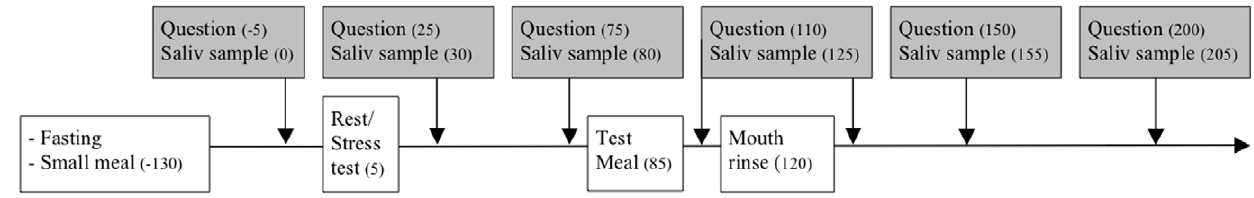
Figure 1. Schematic overview of the study design. Numbers in brackets represent the time points (in min) at which data was collected or tasks were completed. ‘Question’, questionnaires; ‘Saliv sample’, salivary sample.